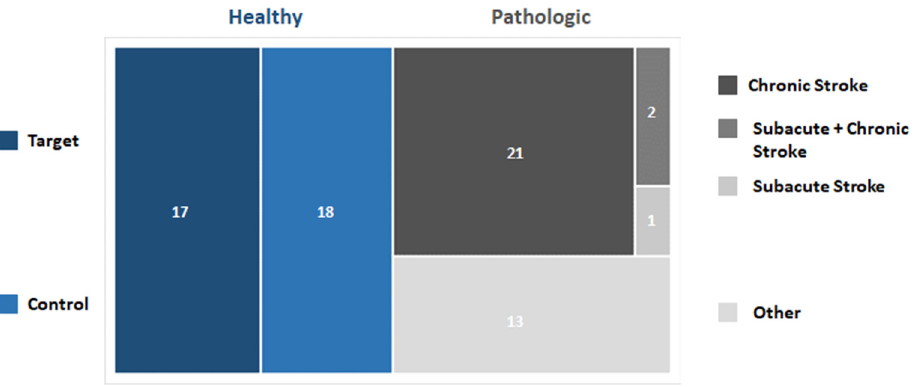
Figure 5. Graph representing the distribution of selected papers based on the cohort of subjects